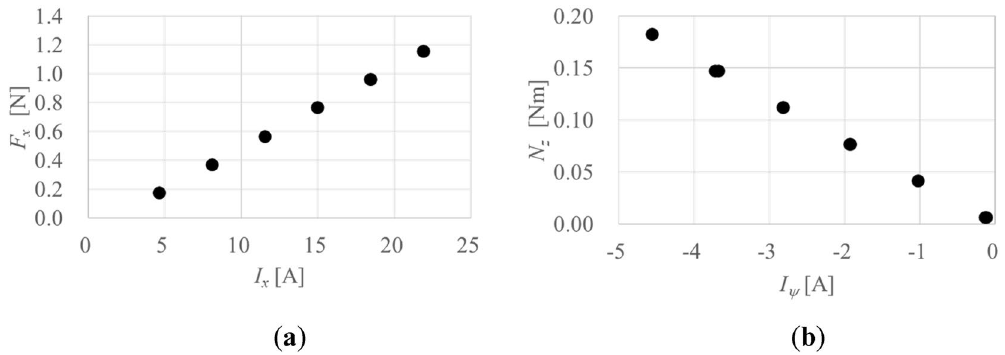
Figure 8. Calibration results: ( a ) F x ; ( b ) N z